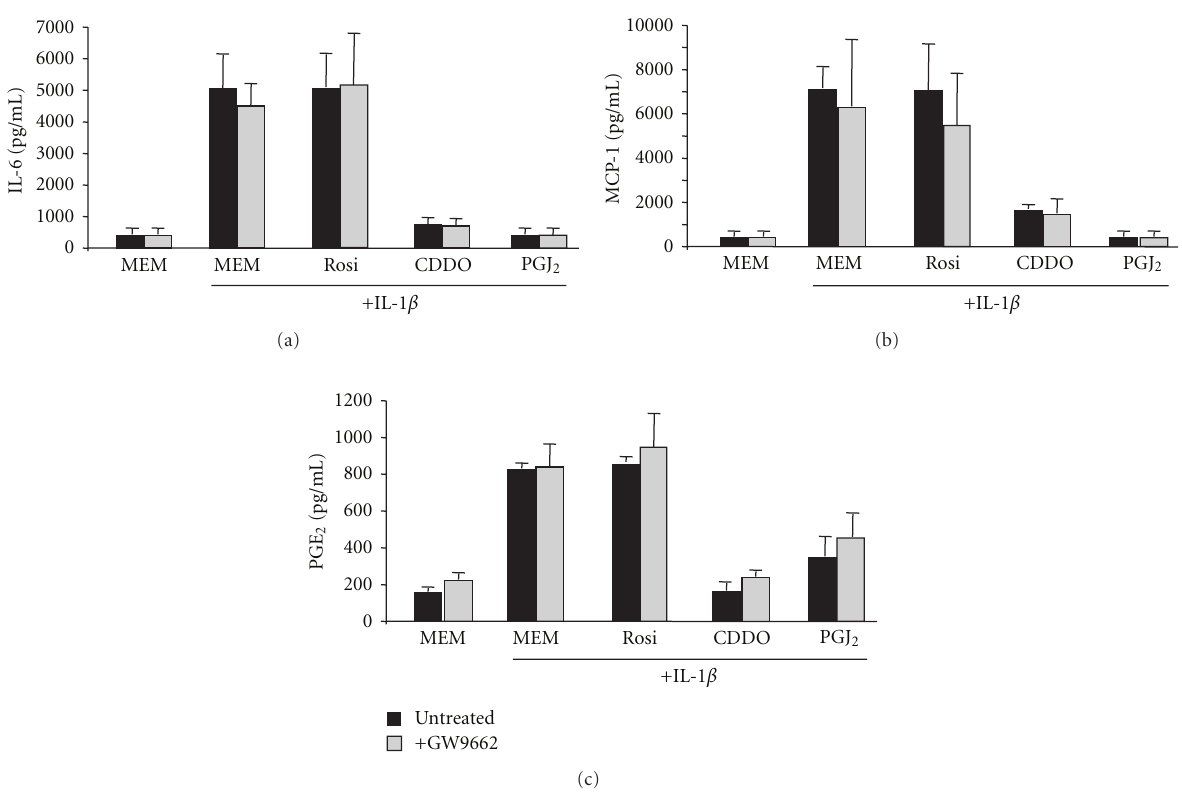
Figure 6: The PPAR γ antagonist GW9662 does not inhibit the anti-inflammatory e ff ects of CDDO and 15d-PGJ 2 . Primary human lung fibroblasts were pretreated with 1 μ M GW9662 for 3 hours, then PPAR γ ligands were added for 1 hour, then 1ng/mL IL-1 β was added for 24 hours. Supernatants were harvested and proinflammatory mediators were measured by ELISA or EIA. (a) IL-6, (b) MCP-1, (c) PGE 2 . Pretreatment with GW9662 did not significantly alter the attenuation of pro-inflammatory mediator production by CDDO or 15d-PGJ 2 alone. Results are mean ± standard deviation for quadruplicate wells and are representative of 2 independent experiments that yielded similar